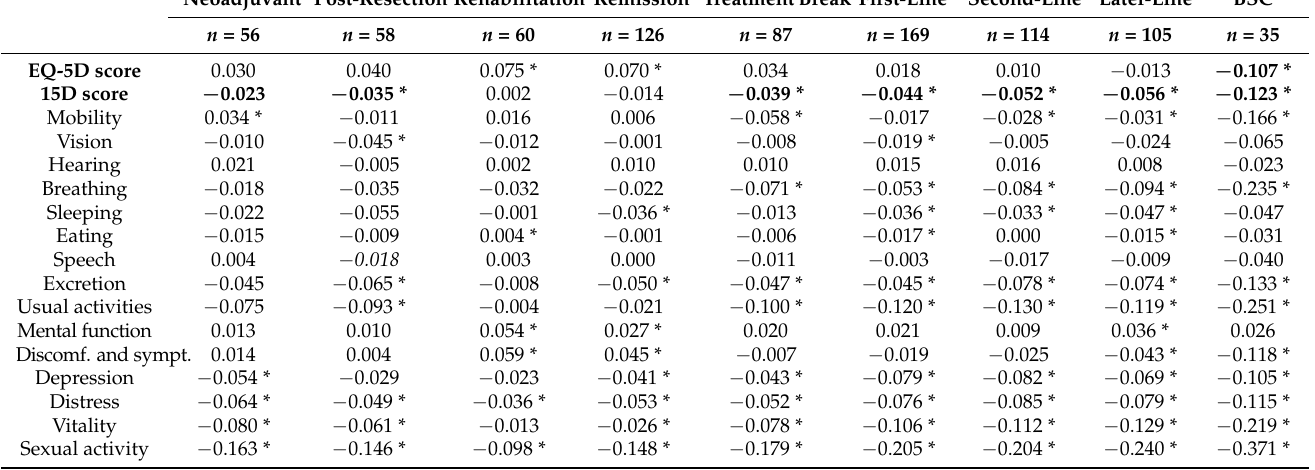
Table 4. The mean health-related quality of life of metastatic colorectal cancer patients compared with that of the standardized general population. Difference from the general population is presented as a negative/positive number that indicates that the patients are on average worse off/better off than the general